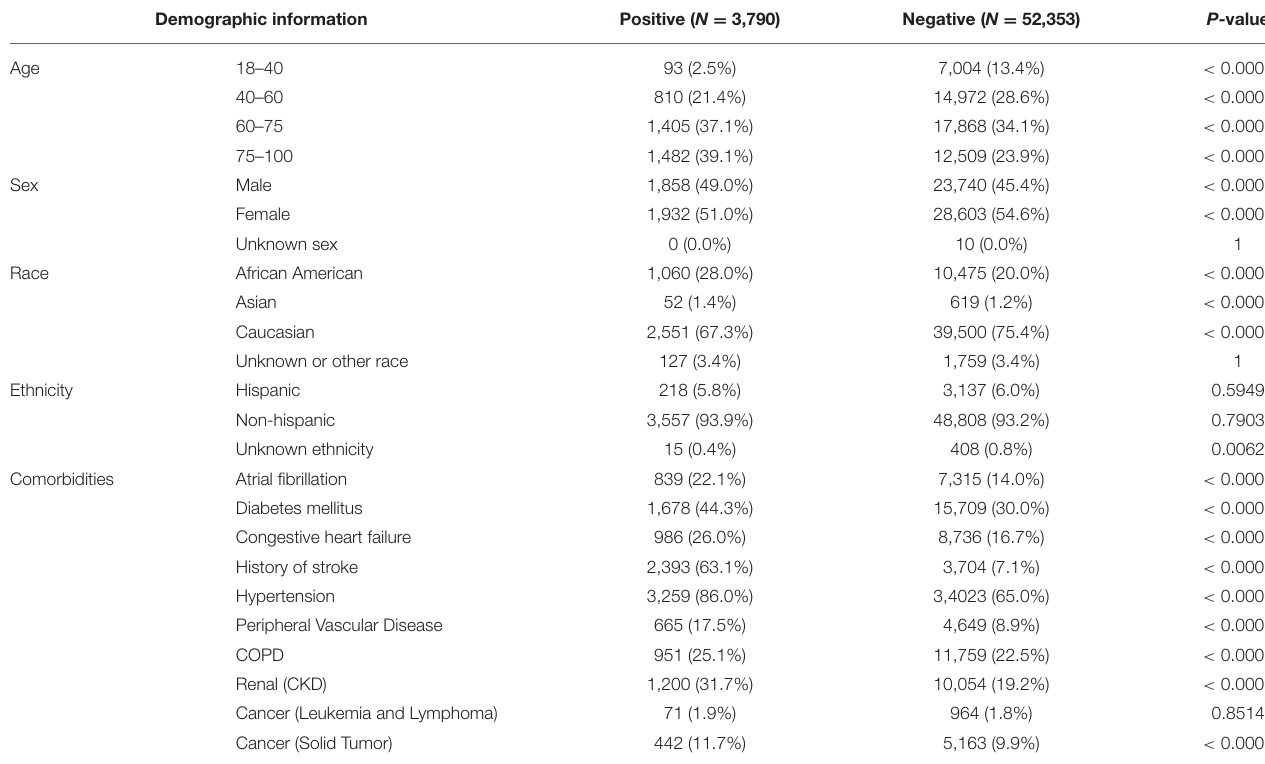
TABLE 4 | Demographic information for the study population sample in the external validation dataset.